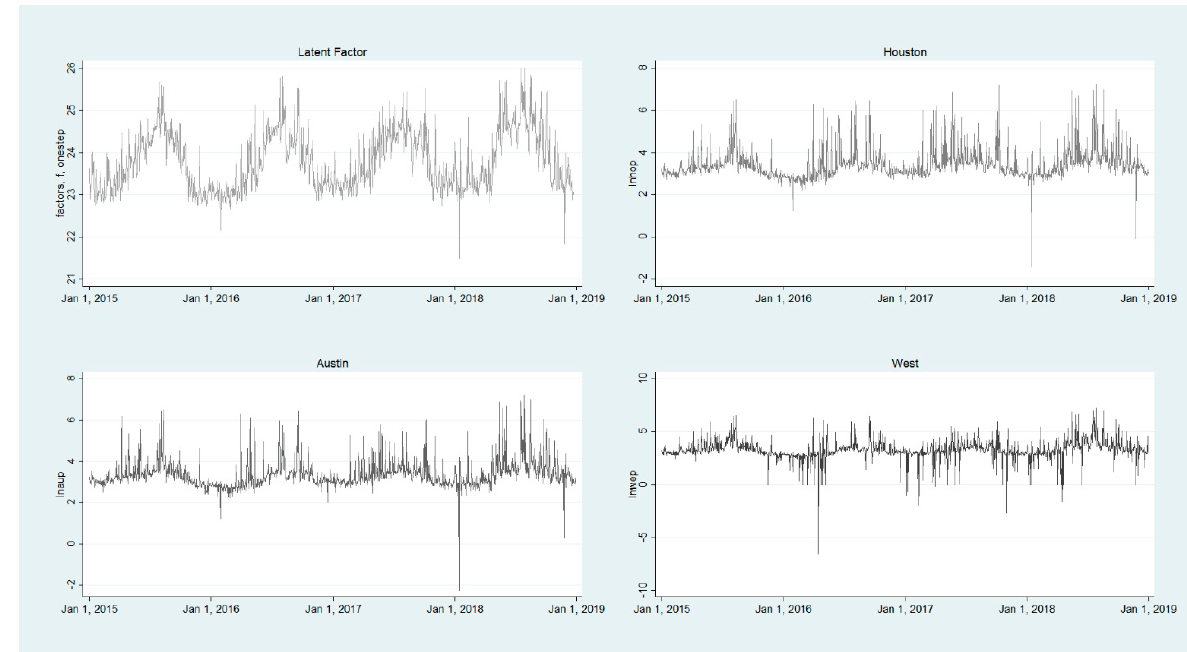
Figure 6. 4:00 p.m.—Latent Factor and Houston price series (top left and right); Austin and West (Bottom left and right).